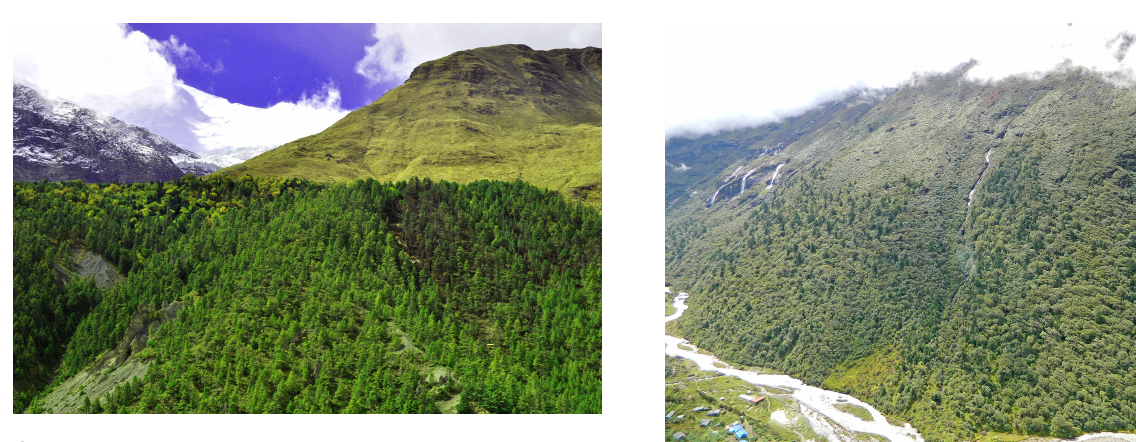
Figure 5. Anthropogenic treeline in Manang, Nepal, showing an abrupt transition to alpine grazing lands (Schickhoff, 24 September 2013). Figure 6. Climatic treeline (3900–4000m) on a north-facing slope in Rolwaling, Nepal (Schwab, 18 September